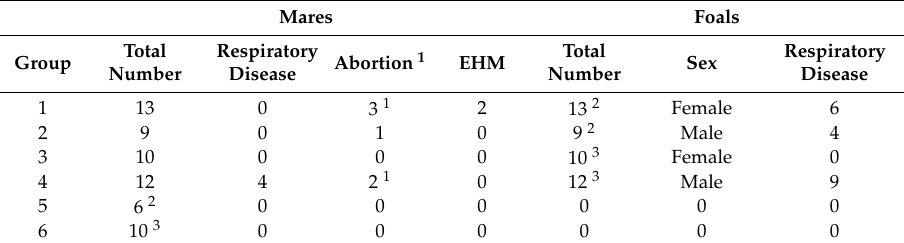
Table 2. Group composition for mares and foals on the French stud farm. Mares Foals Respiratory Total Total Respiratory Sex Group Abortion 1 EHM Disease Number Number Disease 1 13 0 3 1 2 13 2 Female 6 2 9 0 1 0 9 2 Male 4 3 10 0 0 0 10 3 Female 0 4 12 4 2 1 0 12 3 Male 9 5 6 2 0 0 0 0 0 0 6 10 3 0 0 0